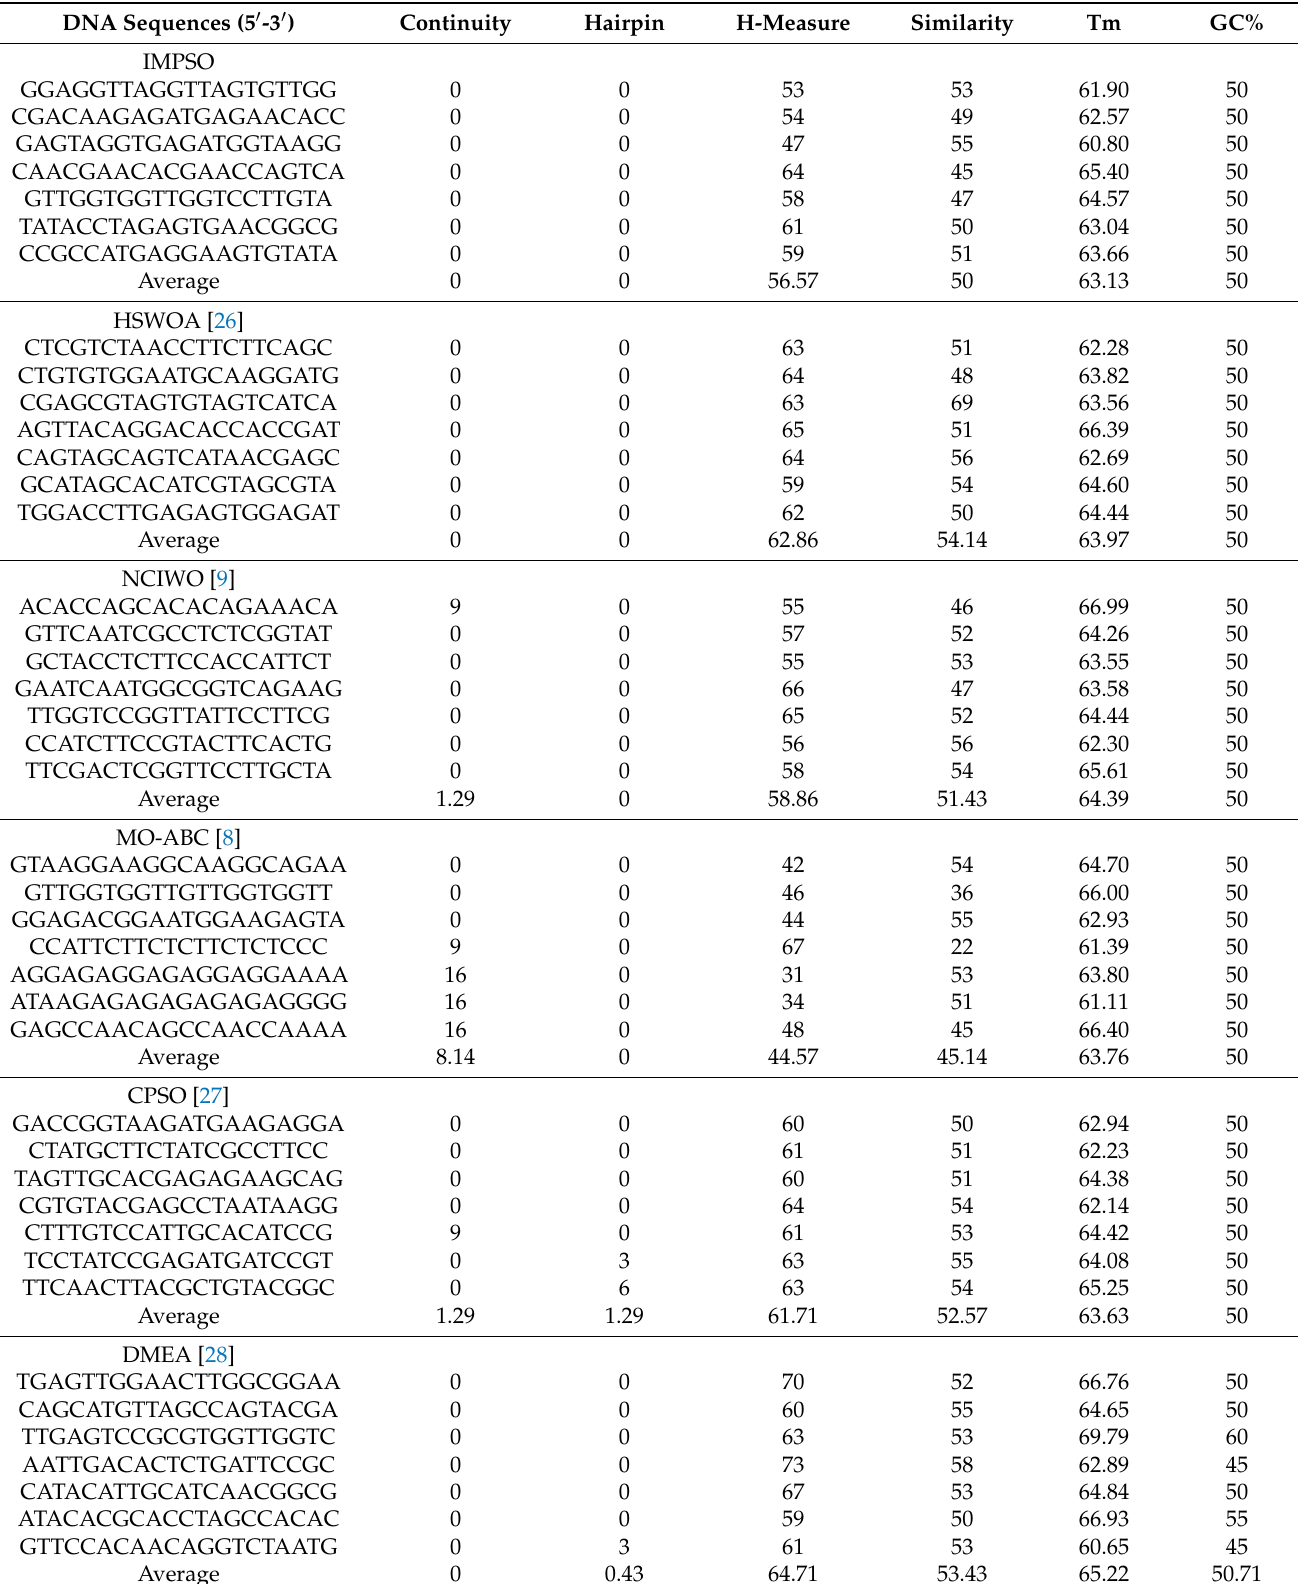
Table 4. Comparison of DNA sequences and corresponding constraint